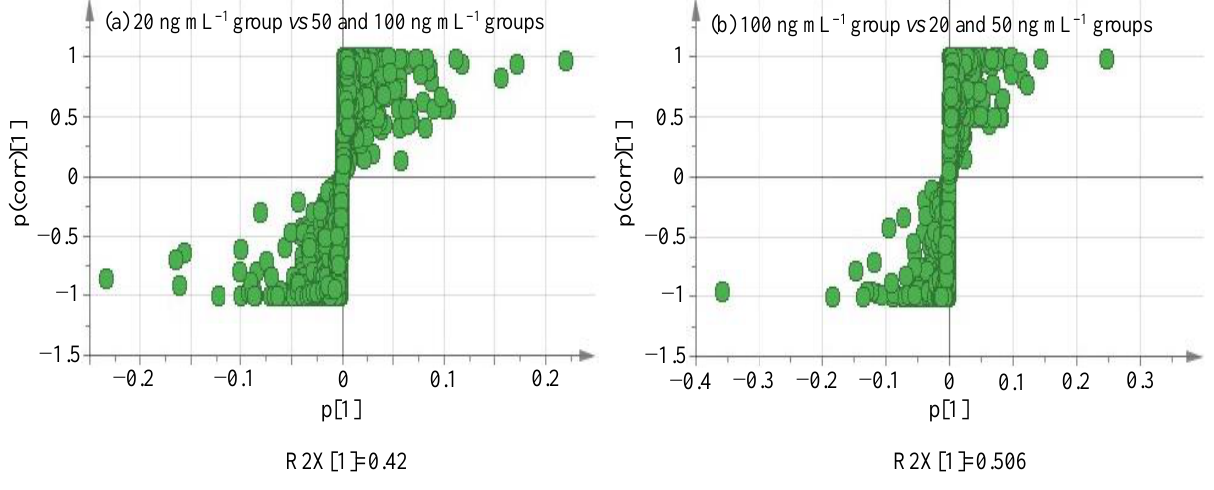
Figure 3. OPLS-DA score plots of spiked lettuce sample groups.